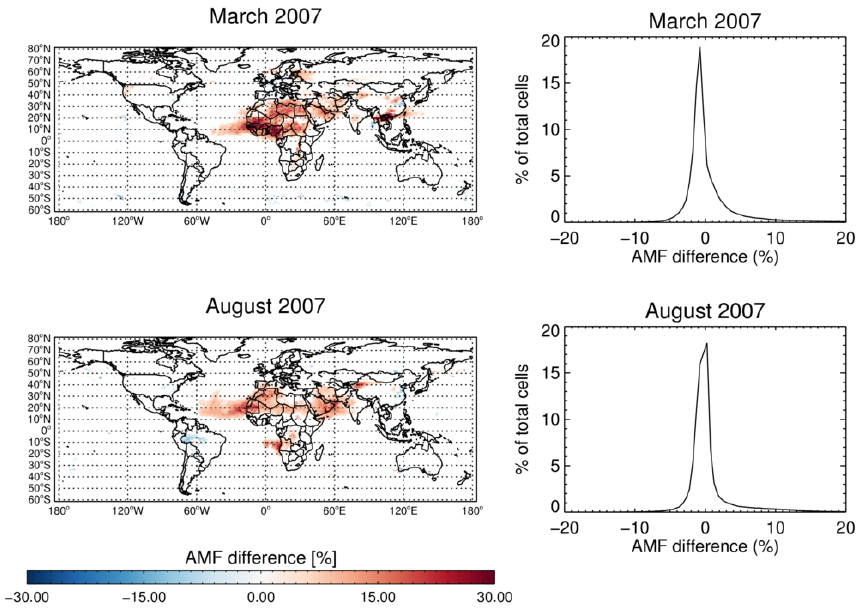
Figure 12. Left: spatial maps of the AMF differences which exceed ± 5%, resulting from the implicit aerosol correction test using the final updated AMF algorithm, as discussed in Sect. 6.2, i.e. 100% × (AMF without AODs – AMF with AODs)/AMF with AODs. The AMFs are gridded to a 0.25 ◦ × 0.25 ◦ using observations with cloud fractions < 40%. Right: corresponding histograms of the AMF